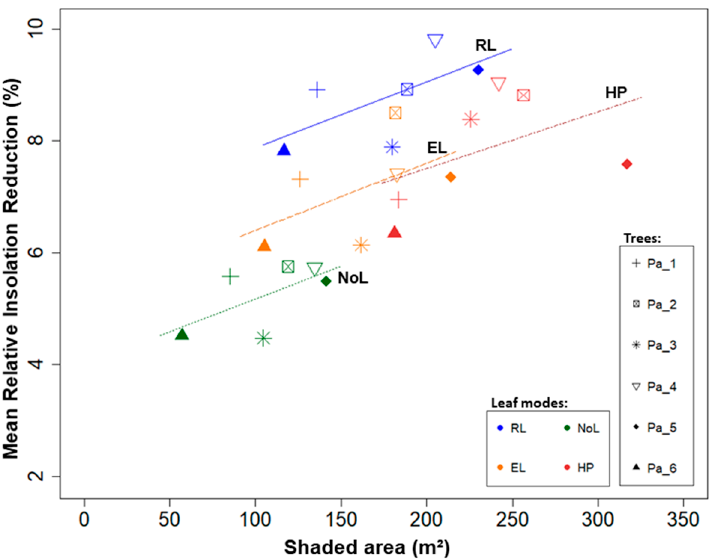
Figure 6. Shaded area versus mean relative insolation reduction of wild cherry trees ( Pa_1 to Pa_6 , by symbols) for different leaf modes (RL, EL, and NoL) and HP (by colours). The shaded area and mean proportion of each shade intensity classes can be observed in Figure 7. Over all simulations, we found a predominant shading effect in the two lowest intensity classes: 51.1% of shaded area are covered by the first class (2–5%), and 25.8% by the second class (5–10%). For RL, it was found an increased proportion of shaded area under the shade intensity classes 20–30% (9.9%) and ≥ 30% (1.3%), compared to EL and NoL. The portion of shaded area under 10–20% insolation reduction was similar between RL and EL, 20.3% and 20.1%, respectively. The shading effects of HP had a particular pattern: they varied in content for all intensity classes, and their proportions were more evenly distributed between classes with a negative exponential